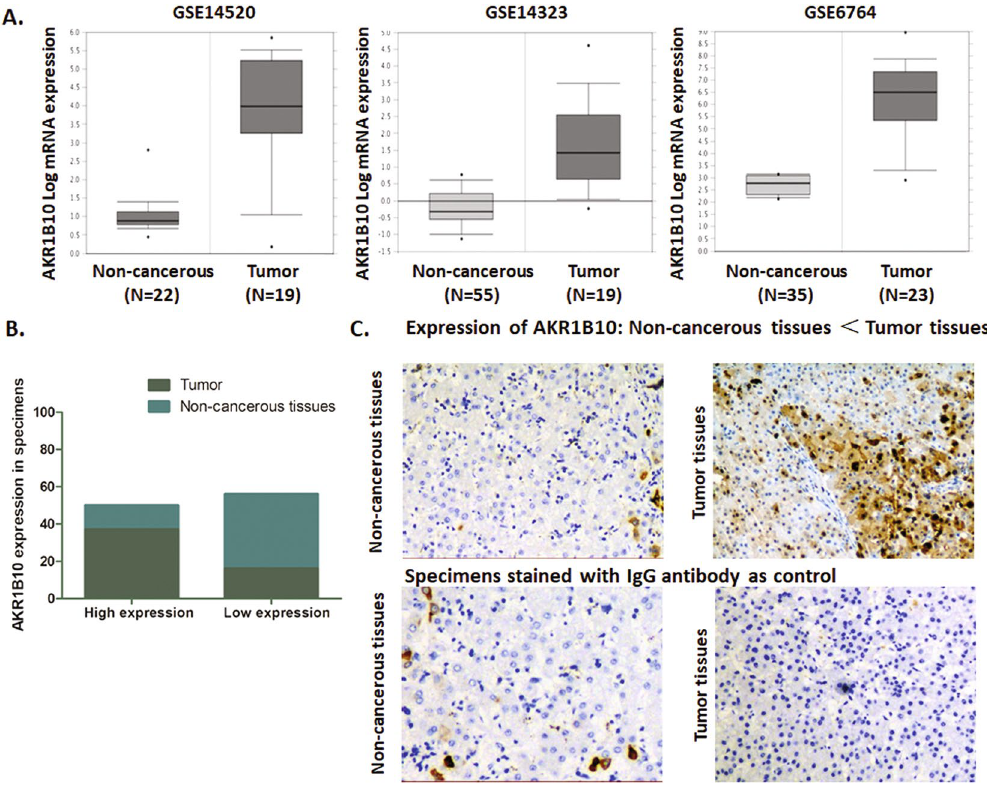
Figure 3. AKR1B10 expression profile in NCBI GEO datasets and HCC patients’ specimens ( A ) Comparison of AKR1B10 mRNA expression status respectively in GSE14520, GSE14323 and GSE6764 liver cancer datasets through t -test. AKR1B10 was significantly higher expressed in HCC tissues than that in the non-cancerous tissues ( P = 3.50E-11 for GSE14323, P = 8.17E-7 for GSE14520 and P = 6.98E-9 for GSE6764). ( B ) Expression of AKR1B10 was high in 69.81% out of 53 HCC tumor specimens (37/53). On the contrary, most of the non- cancerous tissues presented a relative lower AKR1B10 expression. The expression of AKR1B10 in tumor tissues was frequently and significantly higher than adjacent non-cancerous tissues ( P < 0.05). ( C ) Representative graph immunohistochemistry analysis carried out on tissue microarray